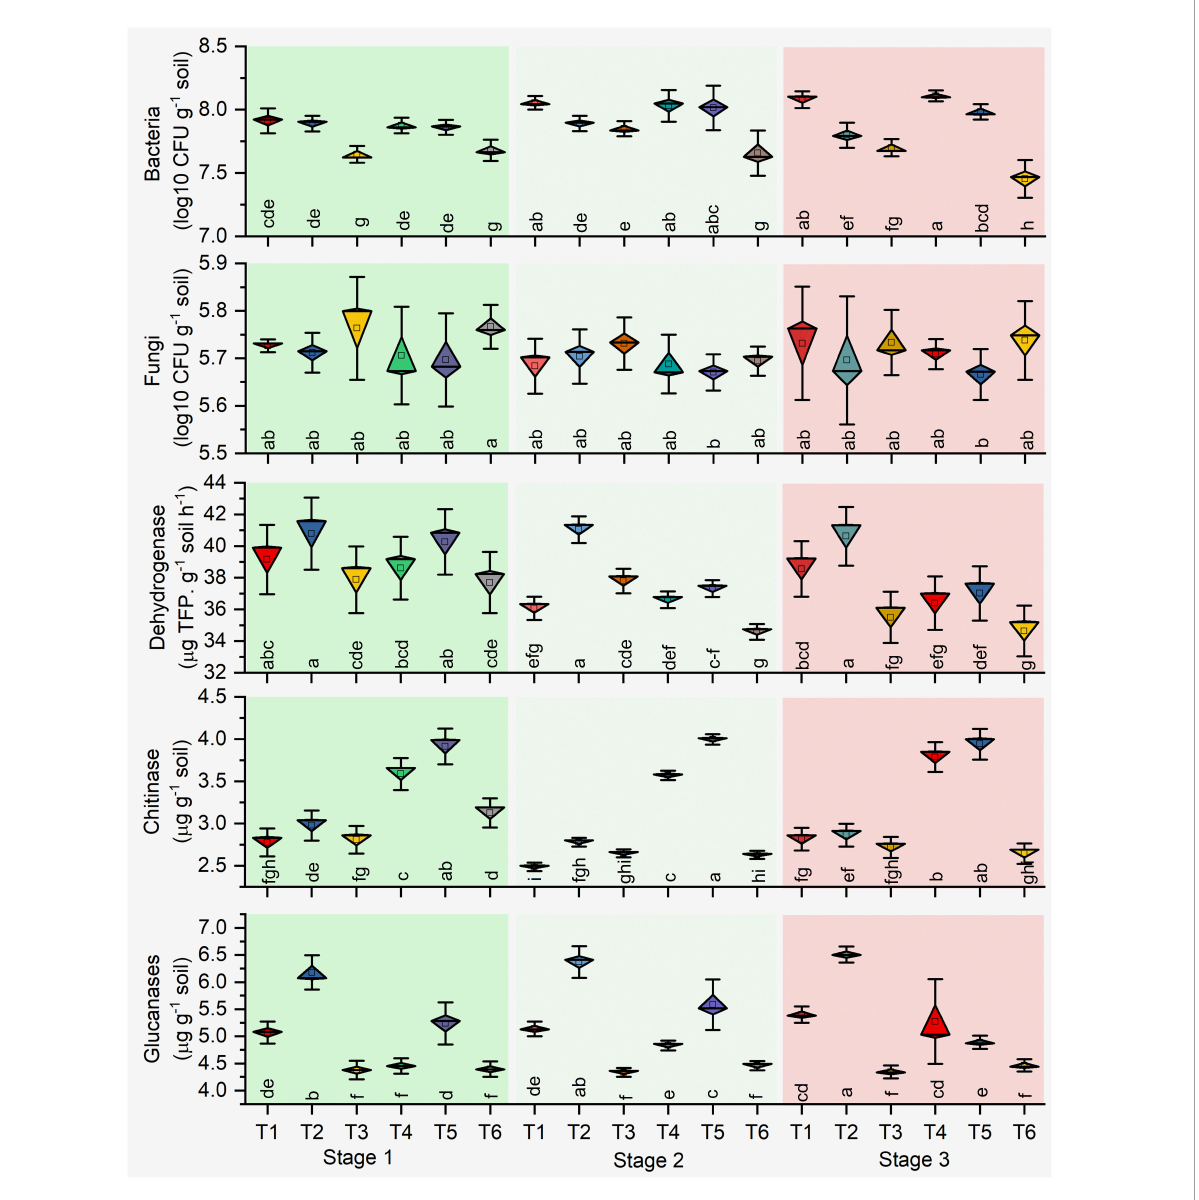
FIGURE2 Impact of pathogen and antagonist treated soil on the microbial count and soil enzymes. Treatments: (T1) Pseudomonas alone, (T2) Bacillus alone, (T3) healthy control (autoclaved liquid suspension without bacteria), (T4) antagonist Pseudomonas + R. solani , (T5) Bacillus + R. solani , and (T6) R. solani alone with autoclaved liquid suspension without bacteria. Stage 1 (vegetative stage), Stage 2 (flowering stage), and Stage 3 (fruit ripening stage). Mean values (n = 3) in the same column followed by the same letter(s) are not significantly different at ( P < 0.05) according to the DMRT